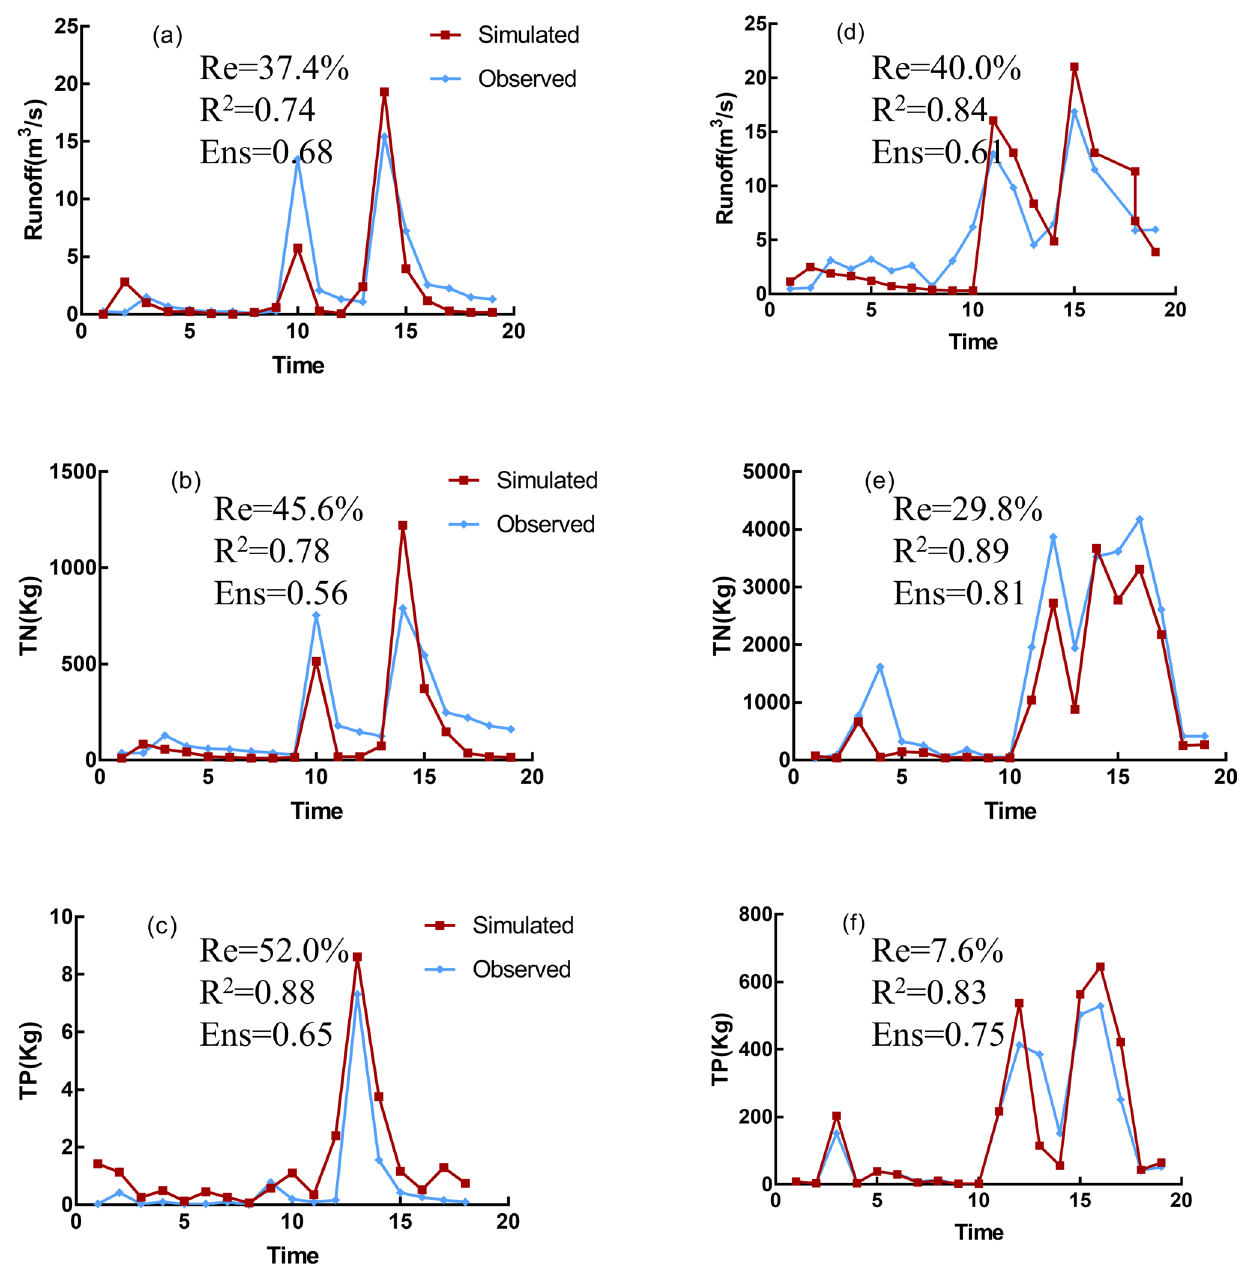
Fig. 7 Comparison between monitored and simulated values in continuous investigation Dongdingjia: a runoff, b TN, c TP; Xijujia: d runoff, e TN, f